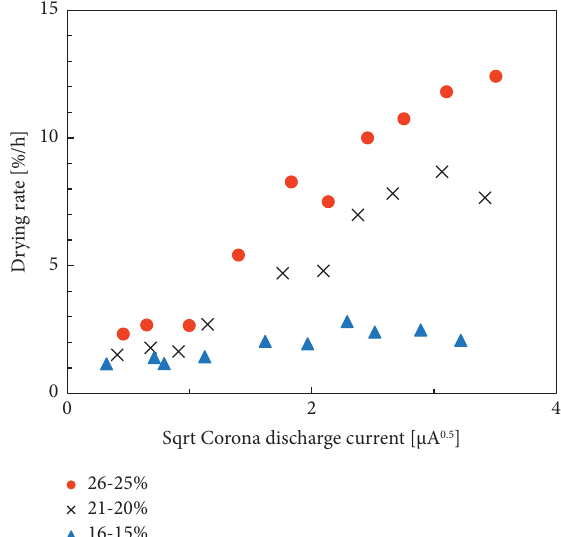
Figure 2: Plot of the drying rate against the sqrt of corona dis- charge current in each moisture content zone.